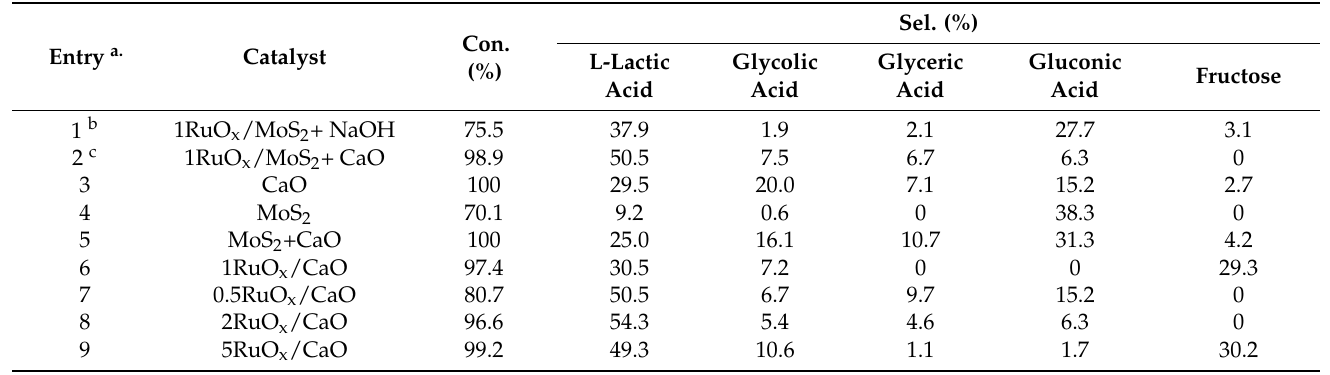
Table 2. Effects of different components via catalysts on the glucose